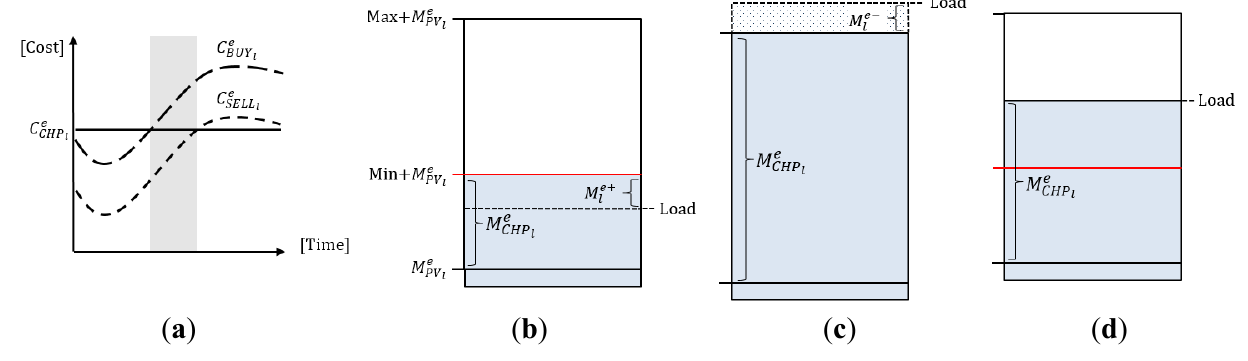
Figure 4. Cases of (cid:1829) (cid:2903)(cid:2889)(cid:2896)(cid:2896)(cid:3032) (cid:4666)(cid:1872)(cid:4667) (cid:3407) C